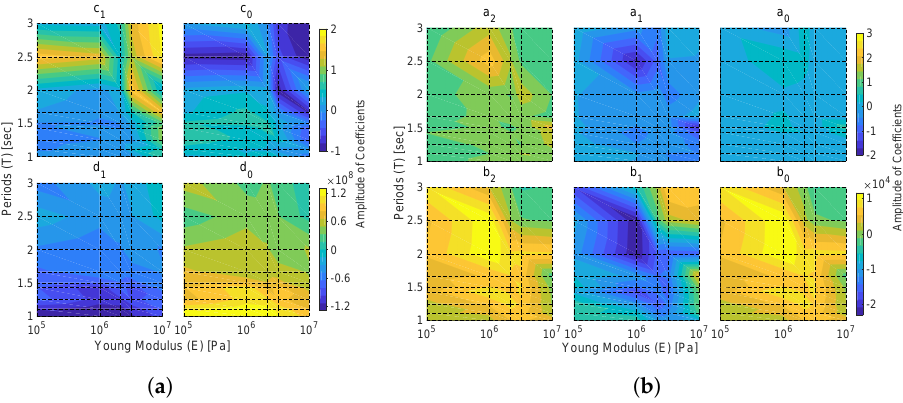
Figure 4. Coefficient fields obtained from the trained model for all the cases in the parametric study. The dotted lines indicate the nine periods T and the five elastic moduli E . In ( a ), we have the maps for the ∆ P coefficients and, in ( b ), the S v coefficients. According to Equations (14) and (15), the values for c 2 in ∆ P and a 3 in S v are always